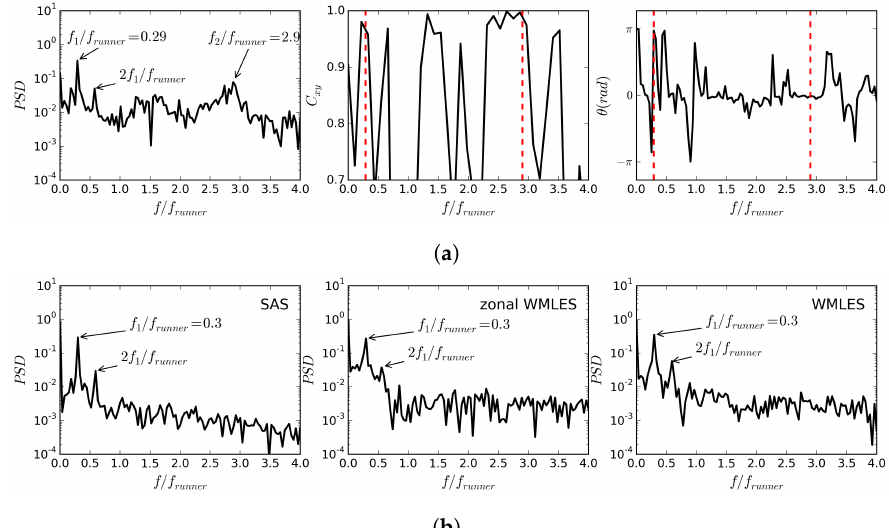
Figure 7. Spectral analysis of pressure signals from Probes 2 and 3 in the draft tube in the experiment and simulations. ( a ) Frequency analysis of pressure signal from Probe 2 (left plot), the coherence (middle plot) and the phase difference (right plot) between the pressure signals from Probes 2 and 3 in the experiment. ( b ) Frequency analysis of the pressure signals from Probe 2 in the draft tube in the simulations with different turbulence modeling techniques.